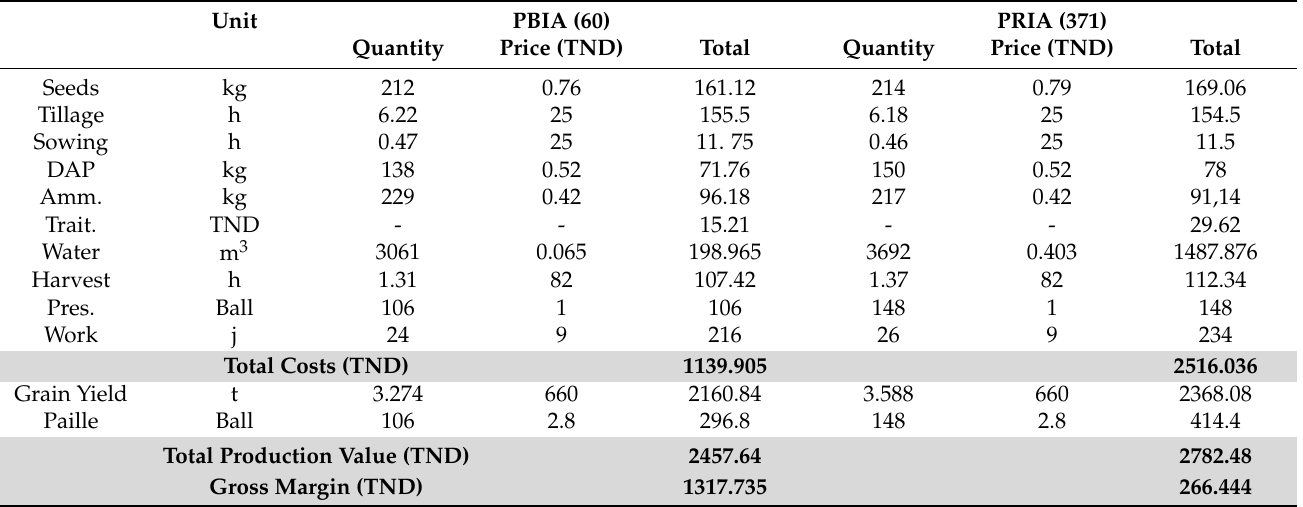
Table 2. Technical and economic sheet of irrigated